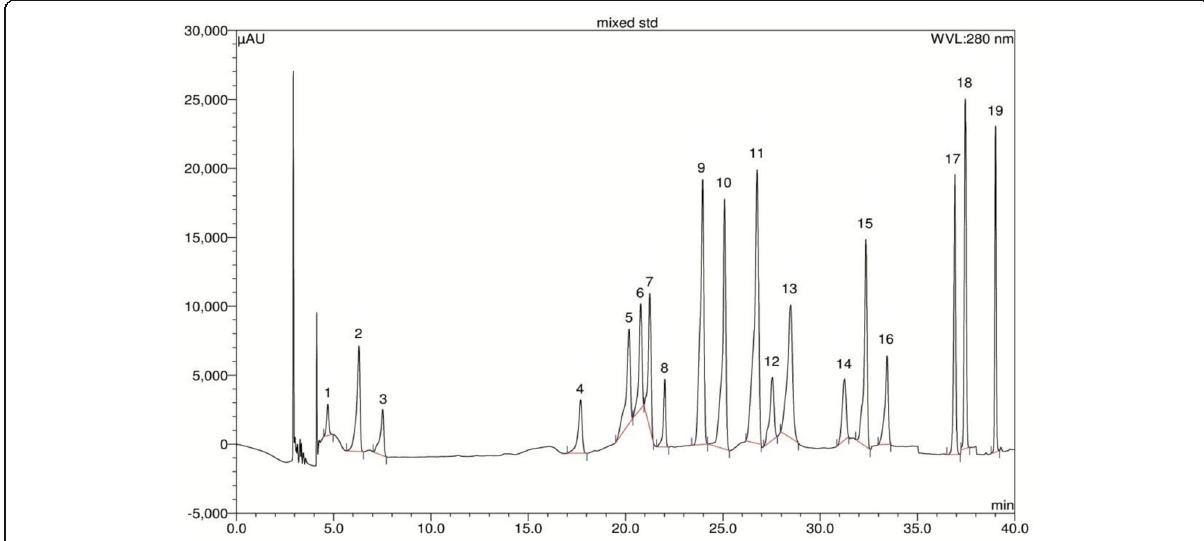
Fig. 2 HPLC chromatogram of 1 ml standard mixture of polyphenolic compounds. Peaks: 1, arbutin (5 µg); 2, gallic acid (4 µg); 3, hydroquinone (4 µg); 4, (+)-catechin hydrate (10 µg); 5, vanillic acid (4 µg); 6, caffeic acid (3 µg); 7, syringic acid (3 µg); 8, ( – )-epicatechin (5 µg); 9, vanillin (3 µg); 10, p -coumaric acid (2 µg); 11, trans -ferulic acid (3 µg); 12, rutin hydrate (6 µg); 13, ellagic acid (10 µg); 14, benzoic acid (8 µg); 15, rosmarinic acid (4 µg); 16, myricetin (4 µg); 17, quercetin (2 µg); 18, trans -cinnamic acid (1 µg); 19, kaempferol (2